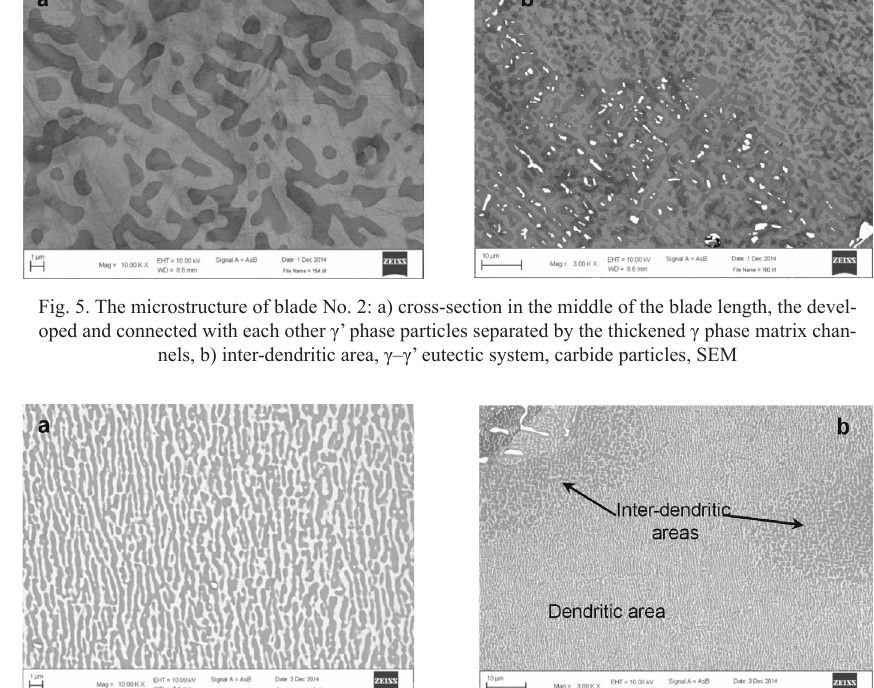
sp cooled blade temperature, b) normal ch at its tip, allowable stress σ and p dop